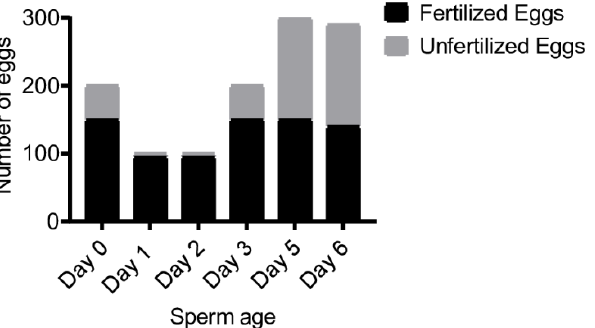
Figure 2. Sperm fertilization capability after short-term storage at 4 °C for as long as 6 d. Each day, 2 × 10 7 sperm cells from the same collection aliquot were used to fertilize freshly collected eggs in 30 mL of FSW. On days 1 and 2, only ~100 eggs were available for IVF. On the other days, a surplus of eggs was collected.